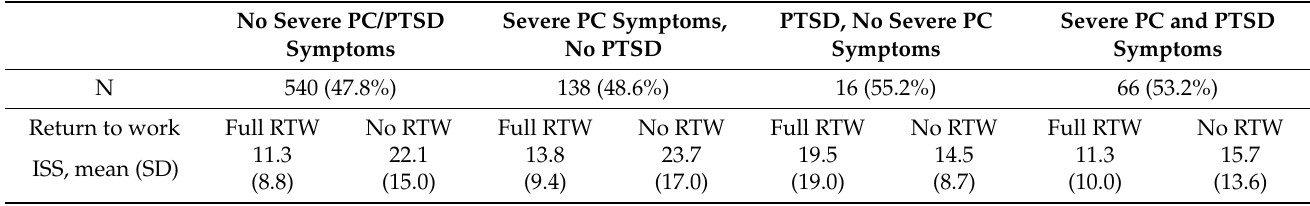
Table A7. Injury Severity Score for patients who returned to work at full level or did not at 6